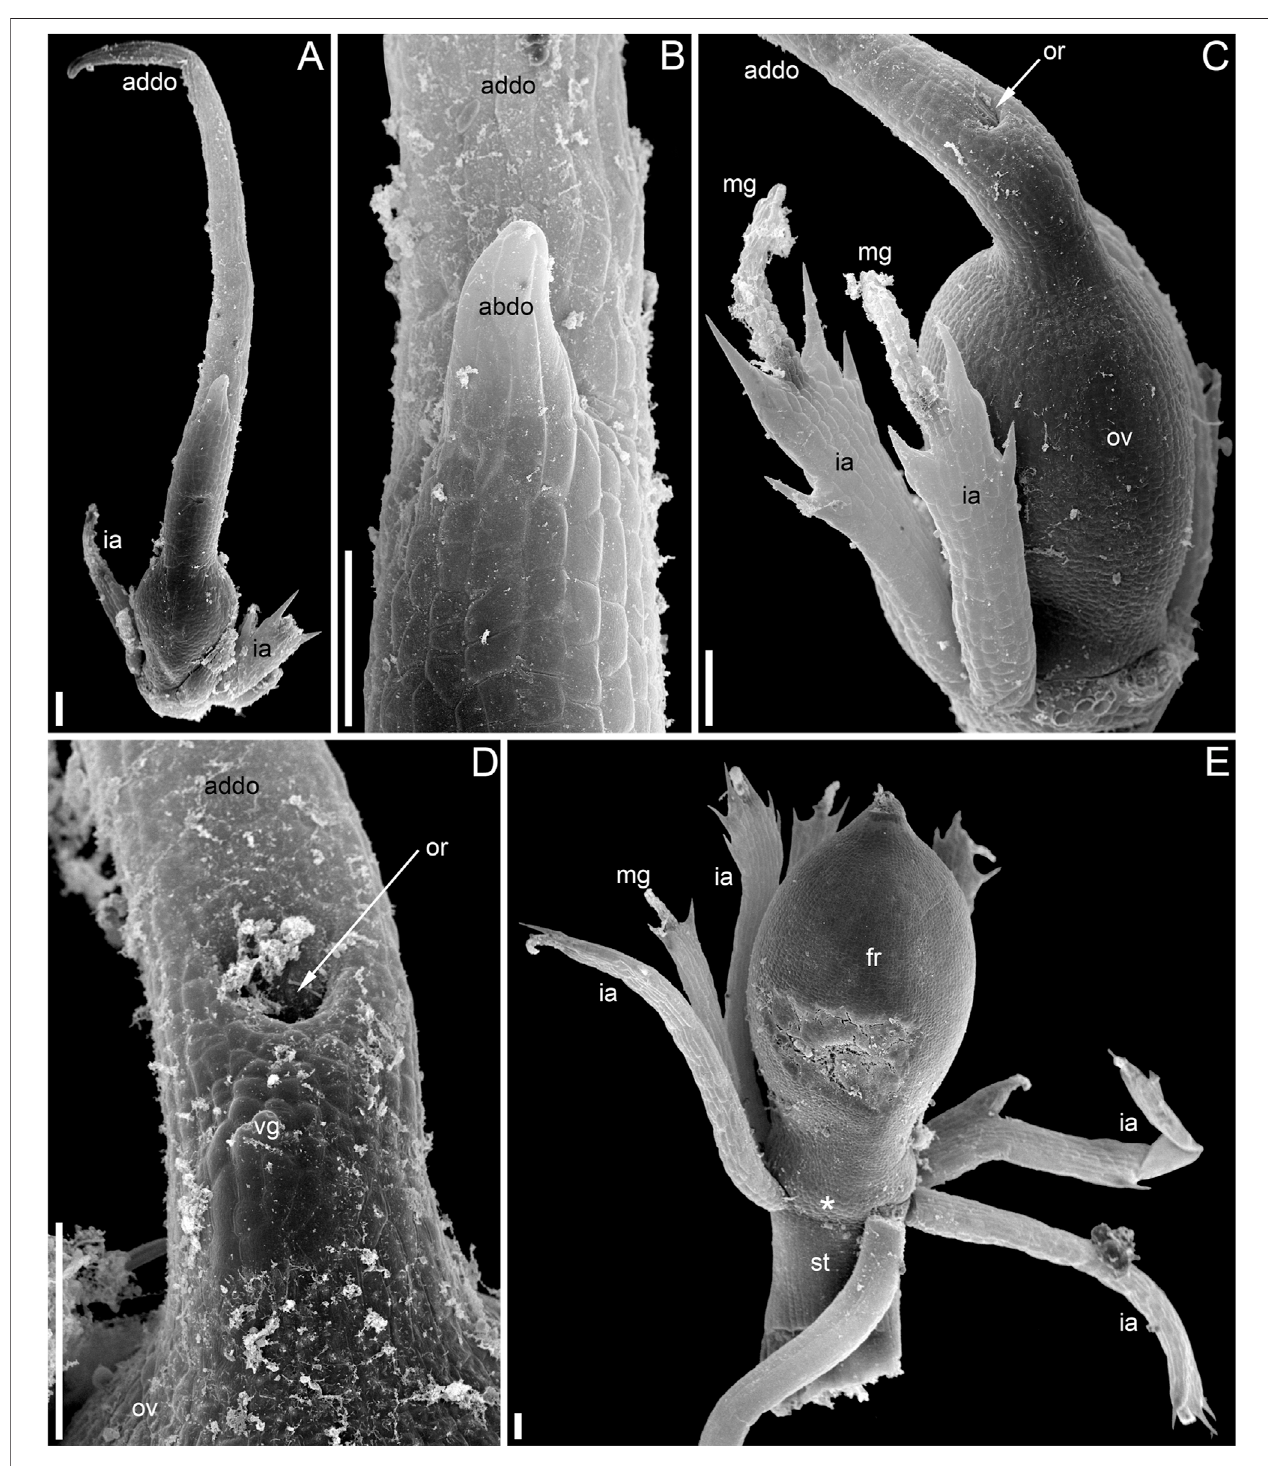
FIGURE 9 | Pistillate fl ower and fruit morphology of Ceratophyllum tanaiticum (SEM). (A) Abaxial view of fl ower with long adaxial and short abaxial distal gynoecial outgrowth. (B) Detail of (A) showing abaxial outgrowth. The gynoecium ori fi ce is hidden by the abaxial outgrowth. (C) Side view of fl ower with a single (adaxial) distal gynoecial outgrowth; twoinvolucral appendages removed, but their scars are visible in the bottom-right part of the image. (D) Detail ofabaxial viewof gynoecium similar to that in (C) , but with a vestigial gland below the ori fi ce. (E) Young fruit; note the ab initio absence of involucral appendages on one side of the fruit base (asterisk). Scale bars = 100 μ m in (A – E)